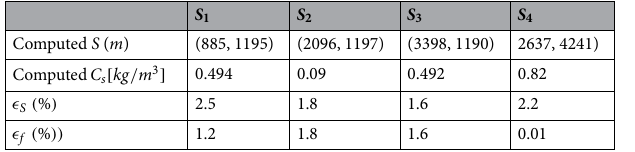
Table 6. Computed wells position and flux from over-specified boundary data and 20 interior observations in the case of 4